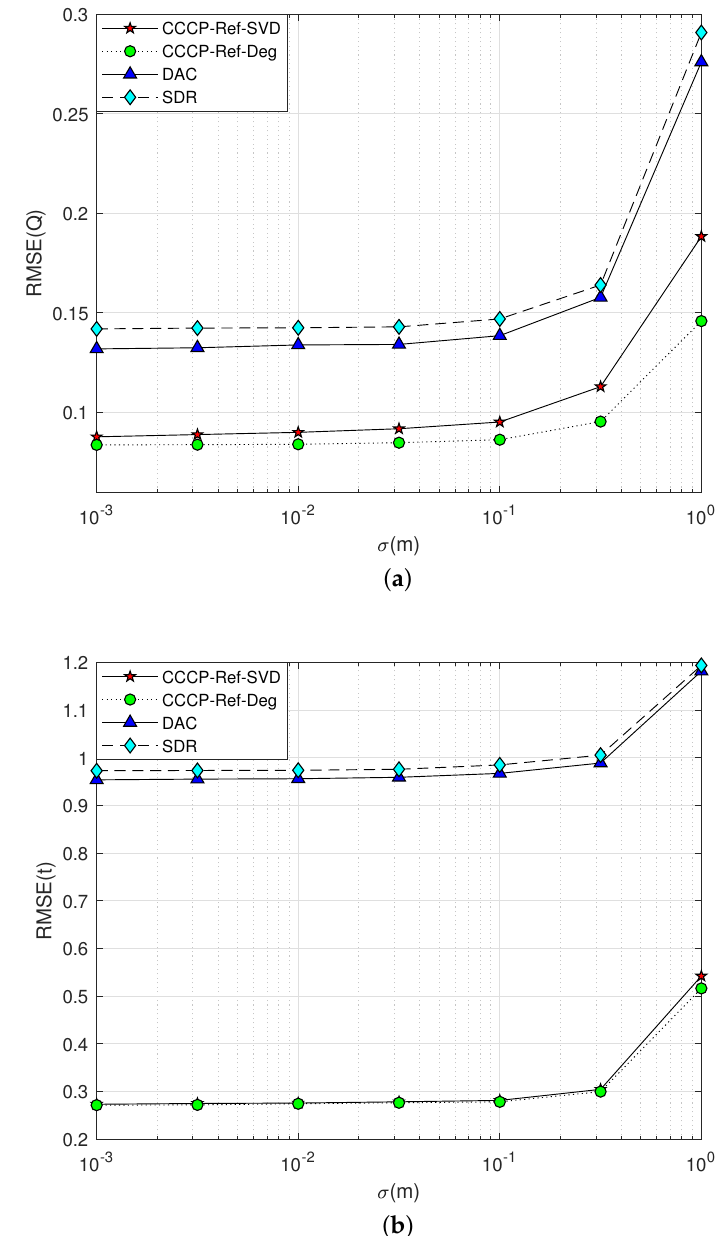
Figure 3. Performance curve of the rigid body’s posture parameter estimation with measurement noise σ mi increasing in a 2–D scenario. ( a ) Q Estimation; ( b ) t